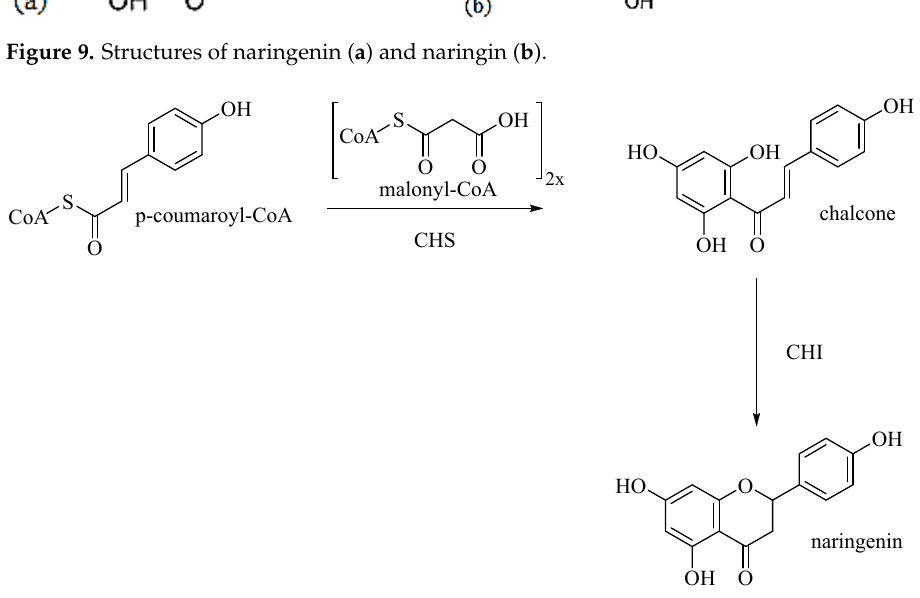
Figure 9. Structures of naringenin ( a ) and naringin ( b ). Figure 10. Biosynthetic pathway of naringenin